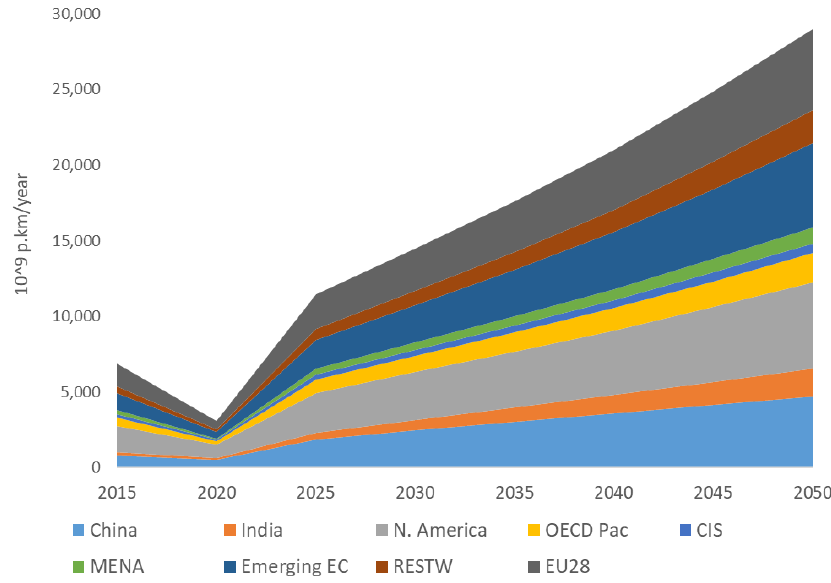
Figure 3. Aviation activity by region in PROMETHEUS REF scenario.